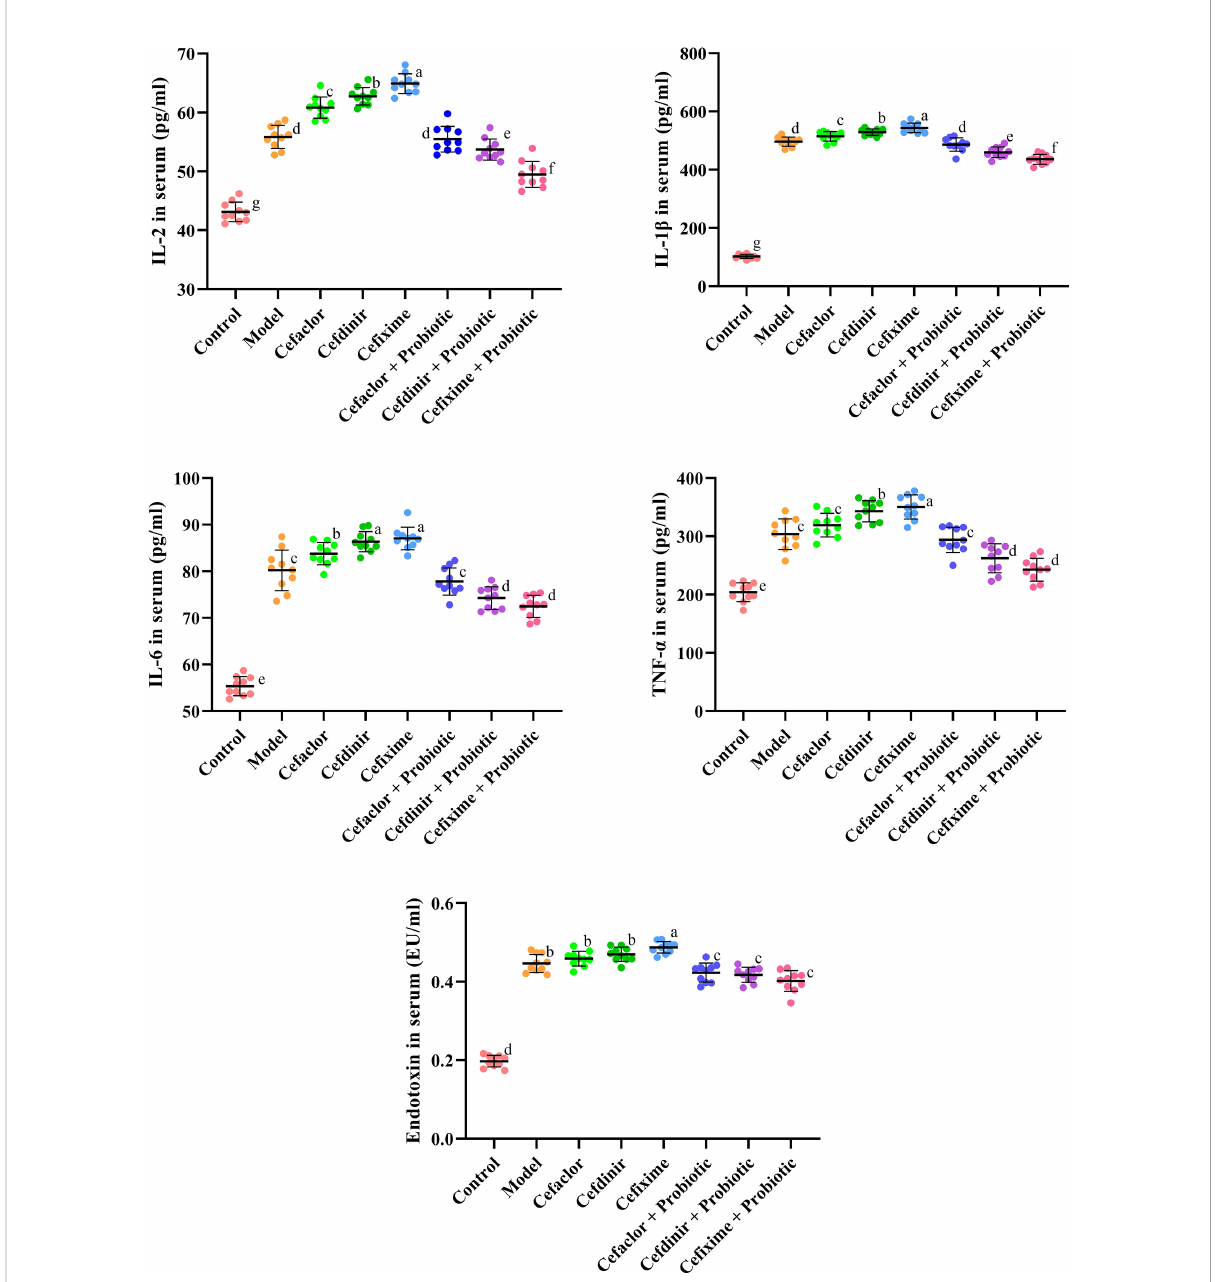
FIGURE 4 Effects of cephalosporins on the production of pro-in fl ammatory cytokines and endotoxin in the serum of Spn-infected mice. Data were showed as mean ± SD. Different letters indicated statistically signi fi cant differences, P